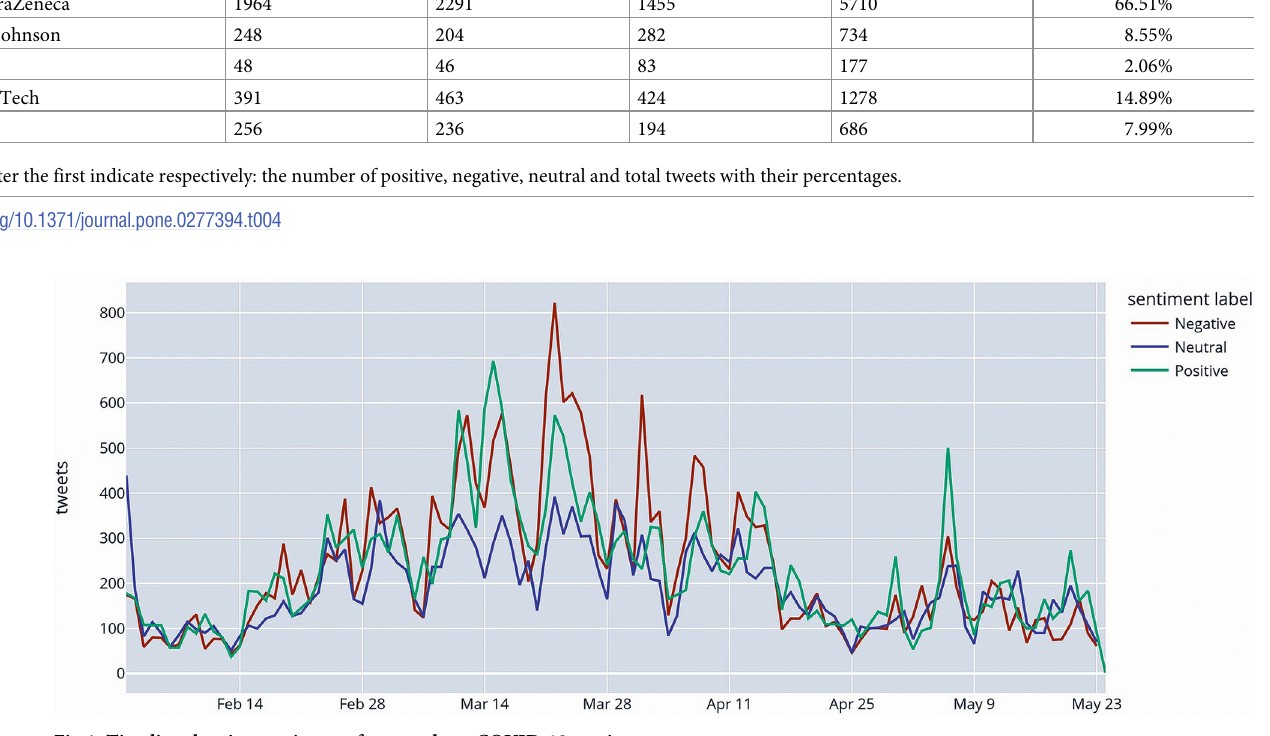
Fig 4. Timeline showing sentiment of tweets about COVID-19